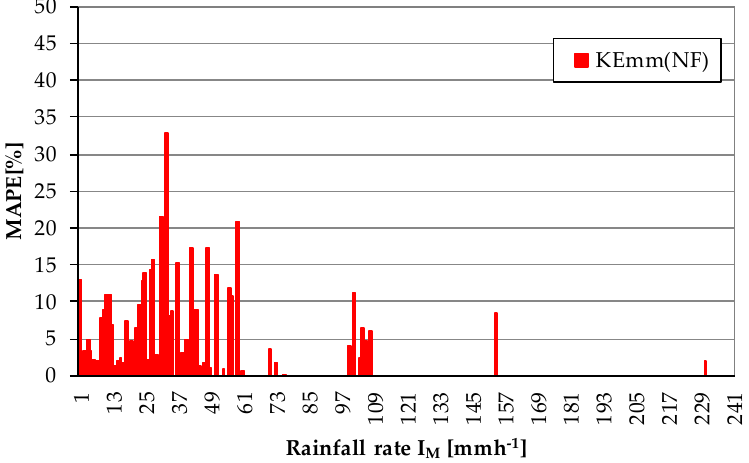
Figure 16. Value of MAPE estimated comparing KE mm(E) and KE mm(NF)